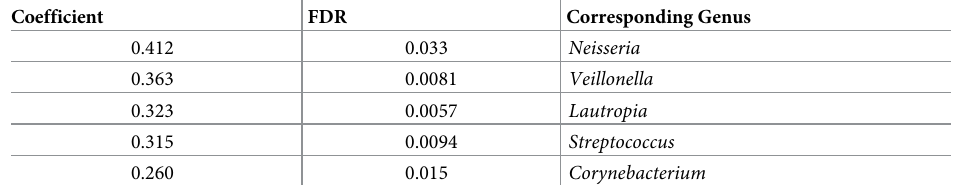
Table 3. Oral wash taxa associated with